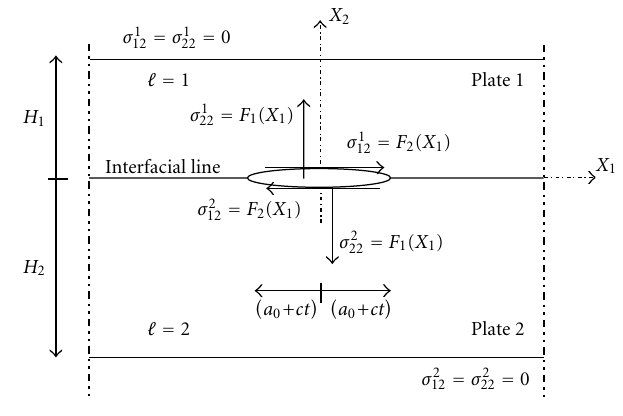
Figure 1.1. Two bonded dissimilar plates containing moving interfacial